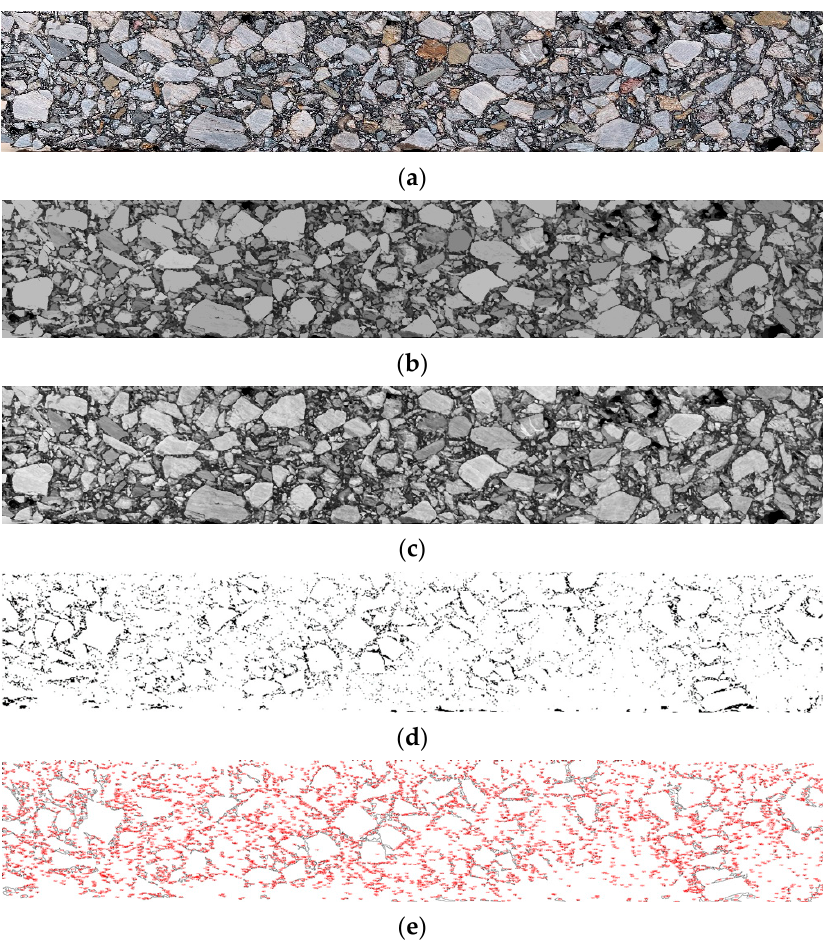
Figure 4. Image processing process: ( a ) original image; ( b ) section image after gray histogram equalization; ( c ) section image after median filtering; ( d ) sectional image after image segmentation; ( e ) air-void feature information.